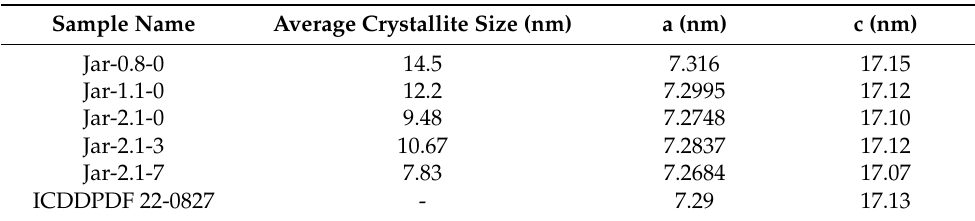
Figure 4. The X-ray diffraction (XRD) spectrums for samples synthesized at different pH values of 0.8 (Jar-0.8-0), 1.1 (Jar-1.1-0), and 2.1 (Jar-2.1-0), and aging time of 0 days (Jar-2.1-0), 3 days (Jar-2.1-3), and 7 days (Jar-2.1-7). Table 2. Crystallite size and lattice parameters of jarosite powders for different aging times and pH